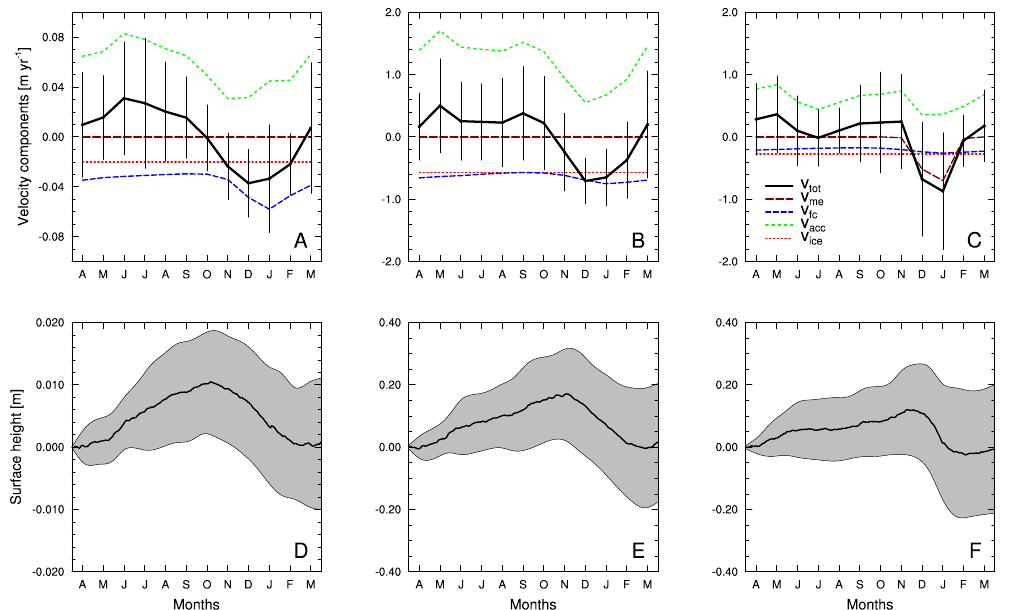
Fig. 9: The monthly averaged (1979–2009) velocity components that determine the vertical displacement of the surface: v acc , v me , v fc , v ice and v tot (A, B, C) and the daily averaged (1979–2009) surface height and standard deviation (D, E, F) for P1, P2 and P3 (see Fig. 2). Note the different